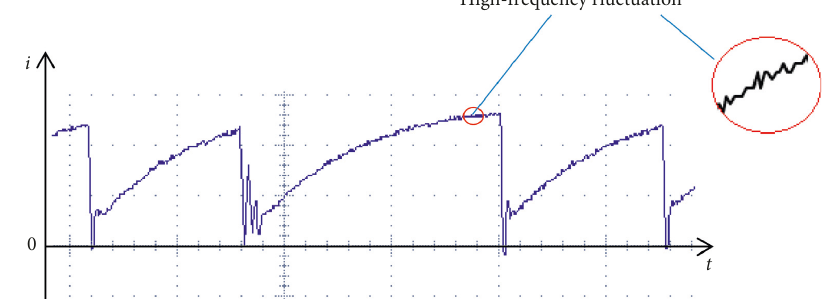
Figure 10: Waveform of the interelectrode discharge current.